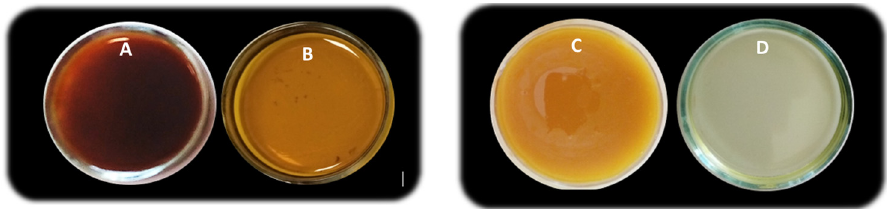
Figure 1. Picture of FDR ( A ), FDR w ( B ), epoxide obtained from FDR ( C ), and epoxide obtained from FDR w ( D ).